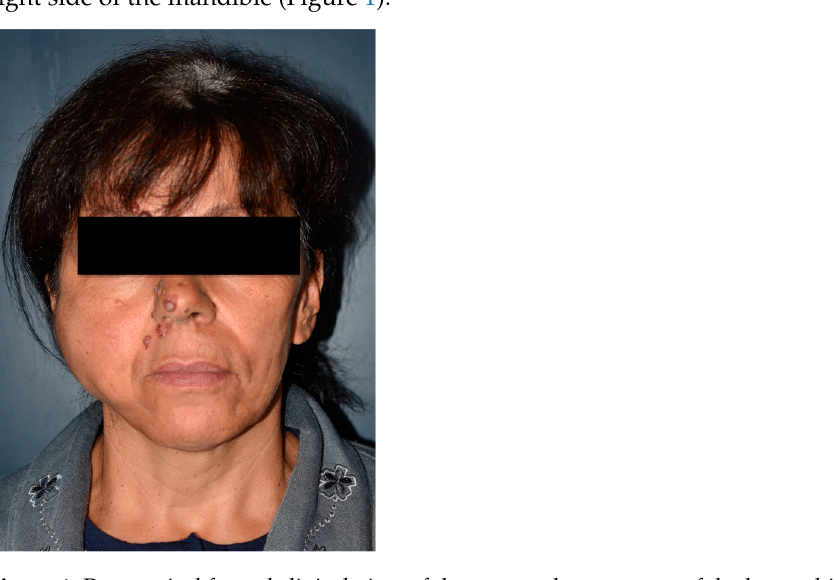
Figure 1. Pre-surgical frontal clinical view of the extraoral asymmetry of the lower third of the face.